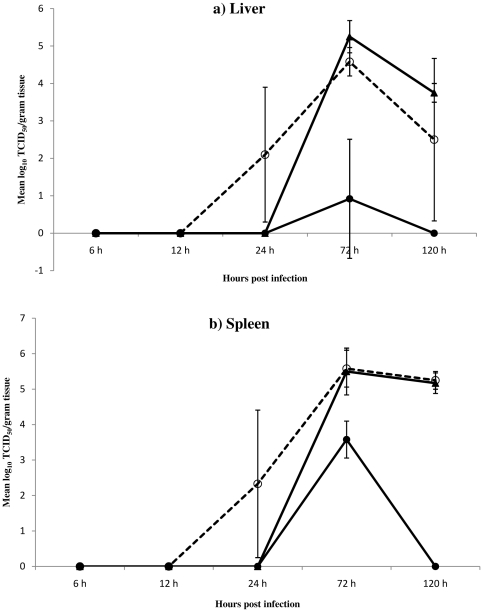
(a–b). Mean viral loads in livers and spleens of RVFV infected mice.Groups, consisting of 3 mice per group per time point, are indicated as: RecNP immunized (–•–), adjuvant control (–o–) and PBS control mice (–▴–). Livers are indicated in panel a, and spleens in panel b.